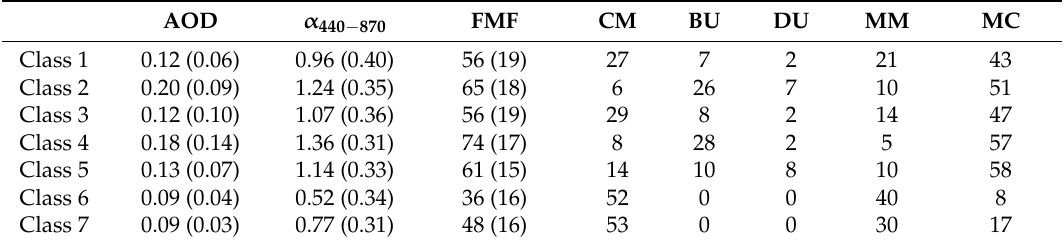
Table 3. Mean values (standard deviation) of the aerosol optical depth at 500 nm (AOD), the Ångström coefficient ( α 440 − 870 ) and the fine mode fraction (FMF; %) as well as proportion (%) of the different aerosol types (CM: clean maritime; BU: biomass burning/urban-industrial; DU: desert dust; MM: mixed maritime; and MC: mixed continental) for the seven classes resulting from the cluster analysis. AOD α 440 − 870 FMF CM BU DU MM